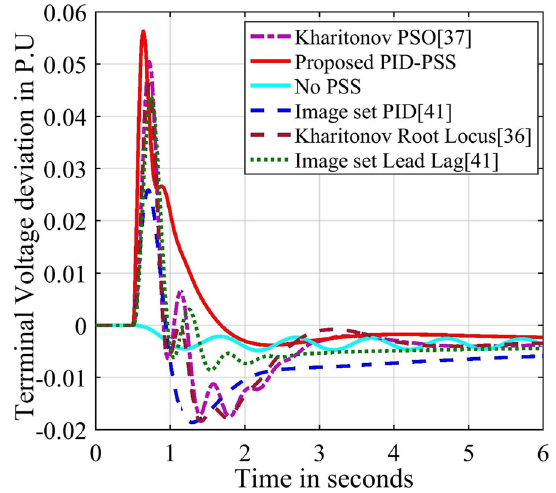
Fig. 16 Comparision of terminal voltage deviation response of the proposed with existing methods to 0.1 p.u. torque disturbance at P = 0.8 p.u. and Q = 0.3